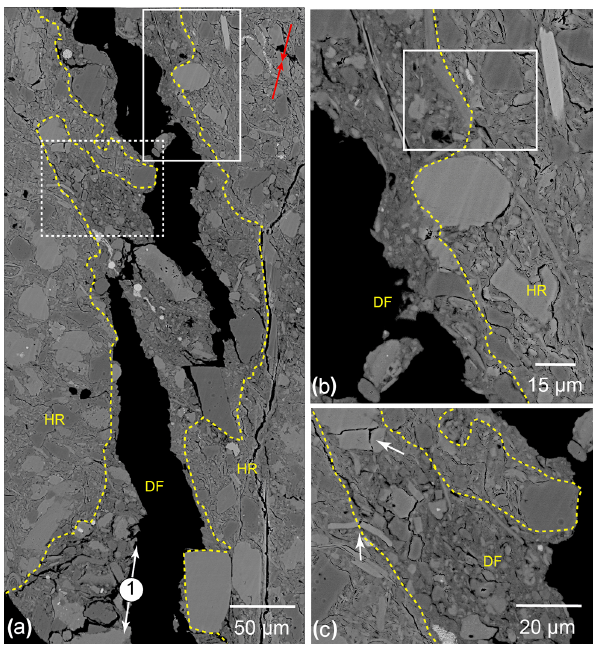
Figure 9. Microstructures of ROI-1 in sample COX-10MPa. (a– c) The damaged fabric (DF) within the main fracture (1) is made of fragments of non-clay minerals derived from the dense, tight clay matrix. (a) The large open fracture in the middle of the main frac- ture (black) is interpreted to develop after the experiment by unload- ing and/or drying (see Sect. 5.1 for details). In (a) the white box in dashed lines refers to (c) , whereas the one in solid lines refers to (b) . (b) Details of difference in mineral fabric between DF and the host rock (HR). The white box refers to Fig. 10. (c) Some grains within the damaged fabric, but close to the boundary between the dam- aged fabric and the host rock, show transgranular fracturing (white arrows). In all micrographs, the orientation of the principal stress ( σ 1 ) is indicated by red arrows. The bedding is perpendicular to σ 1 . The dashed yellow lines indicate the boundaries between DF and